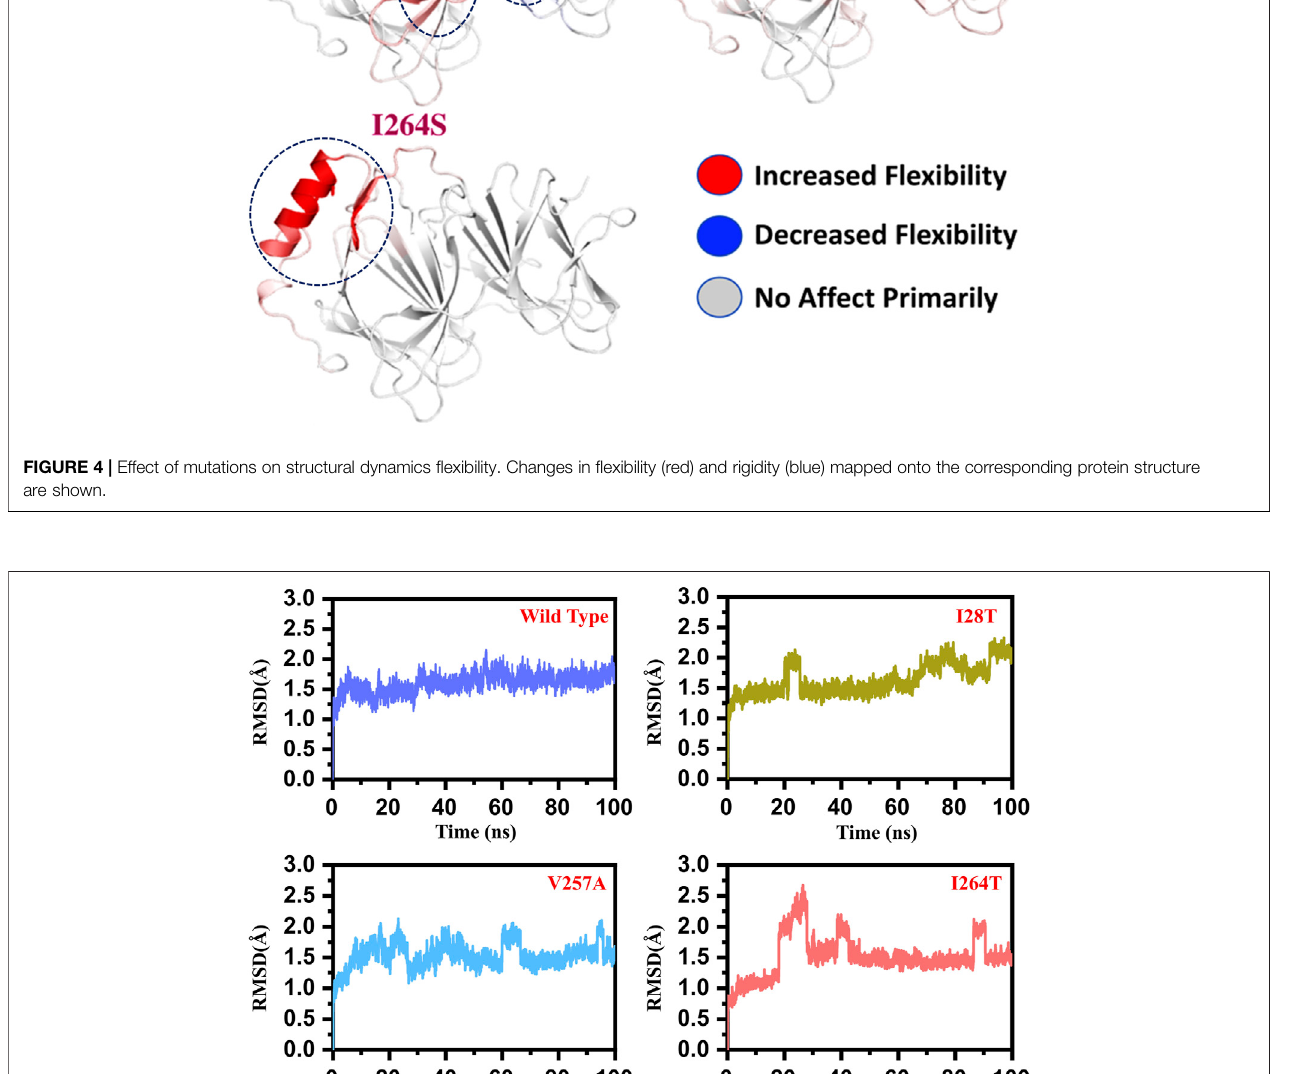
Frontiers in Molecular Biosciences |